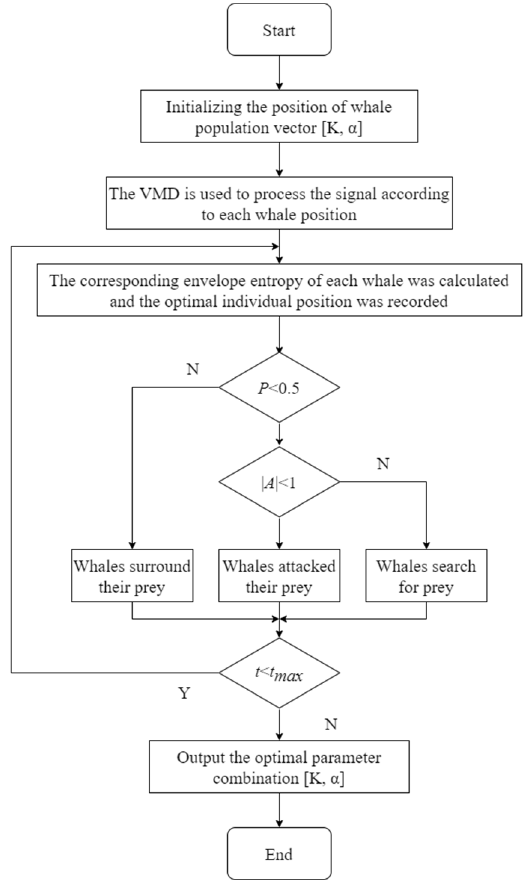
Figure 1. Variational mode decomposition parameters optimization process by whale optimization algorithm.